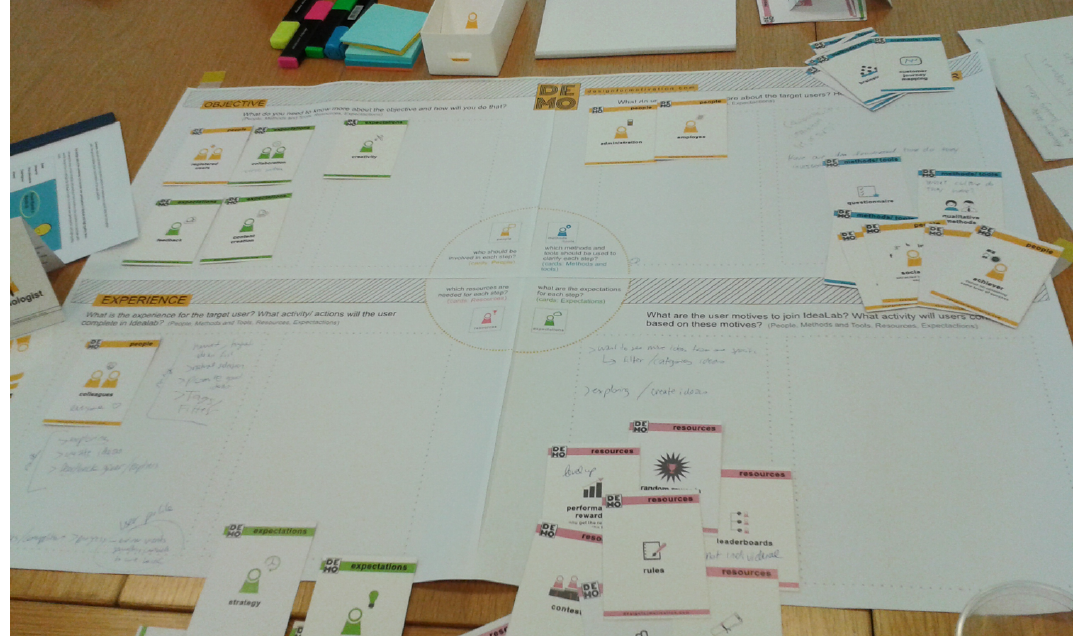
Figure 5. Screenshot from a workshop with generated material.